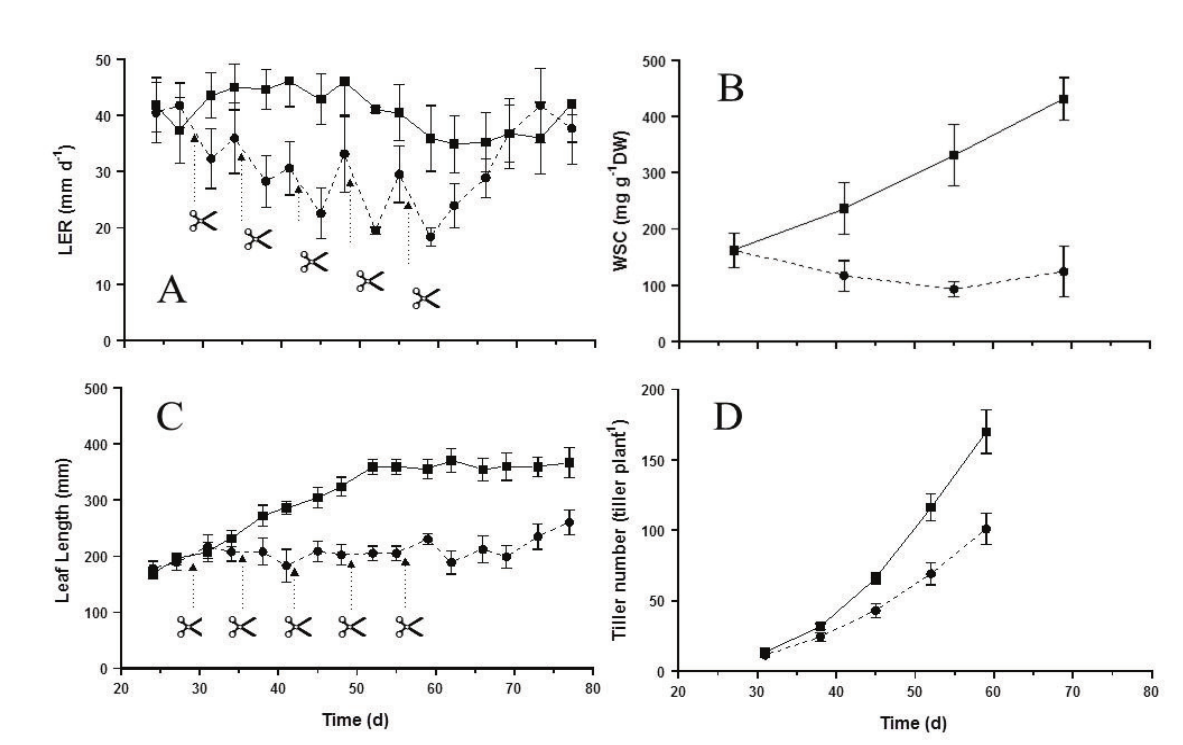
Figure 3. Effect of a sequence of 5 successive weekly defoliations ( ) applied to ryegrass plants, followed by a lax period allowing leaf growth recovery, on leaf elongation rate per tiller (LER, A ),water-soluble carbohydrate concentration (WSC) in the leaf base ( B ), final leaf length ( C ) and tiller number per plant ( D ). ■ Undefoliated control plants; ● defoliated plants; d: day. Arrows indicate timing of the successive defoliations. Plants were grown under constant controlled conditions. Defoliated plants were clipped at a 5-cm stubble height